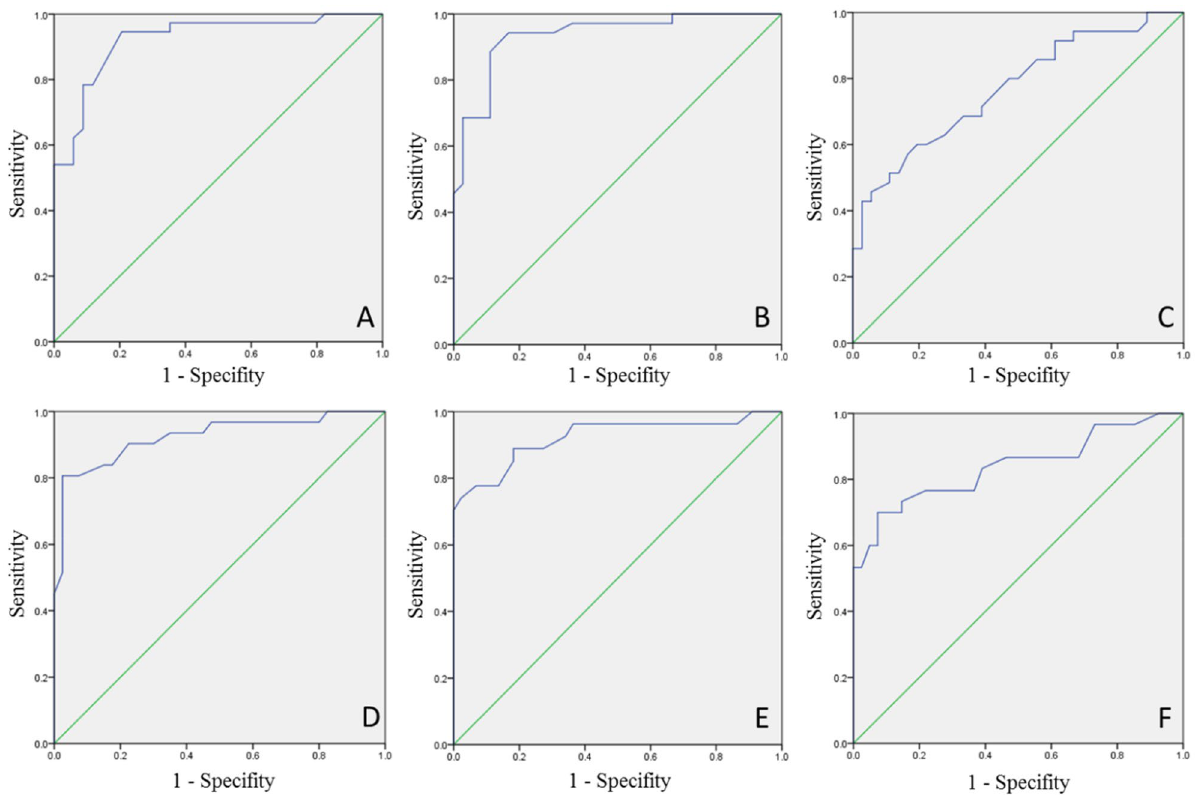
Figure 2. Receiver operating characteristic curve for systolic ( A ) 24 h, ( B ) awake, ( C ) asleep and diastolic, ( D ) 24 h, ( E ) awake and ( F ) asleep BP levels.